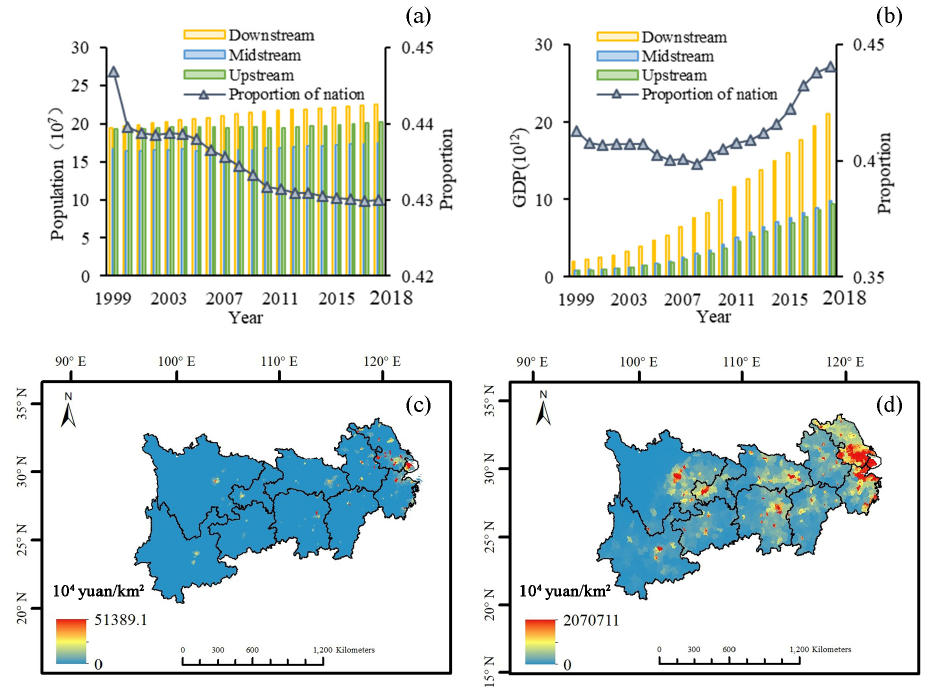
Figure 2. Economic and social development situation of the YREB (( a ): population; ( b ): GDP; ( c ): GDP spatial distribution during 1999–2008; ( d ): GDP spatial distribution during 2009–2018).